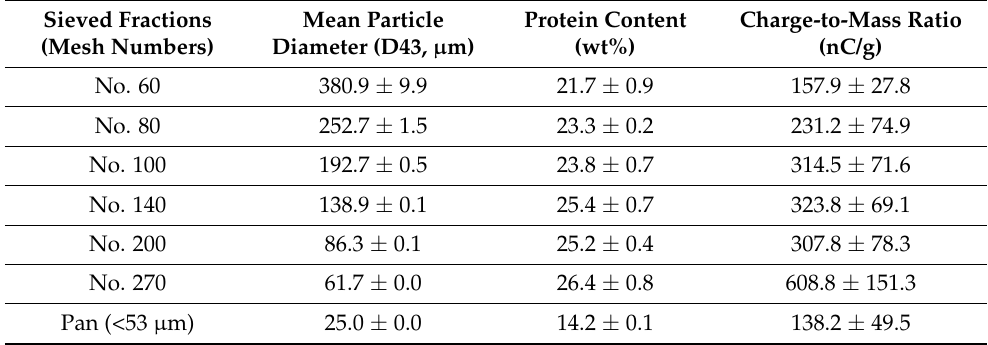
Table 2. Mean diameter (D4,3), protein content and charge-to-mass ratio (nC/g) of yellow pea sieved fractions.